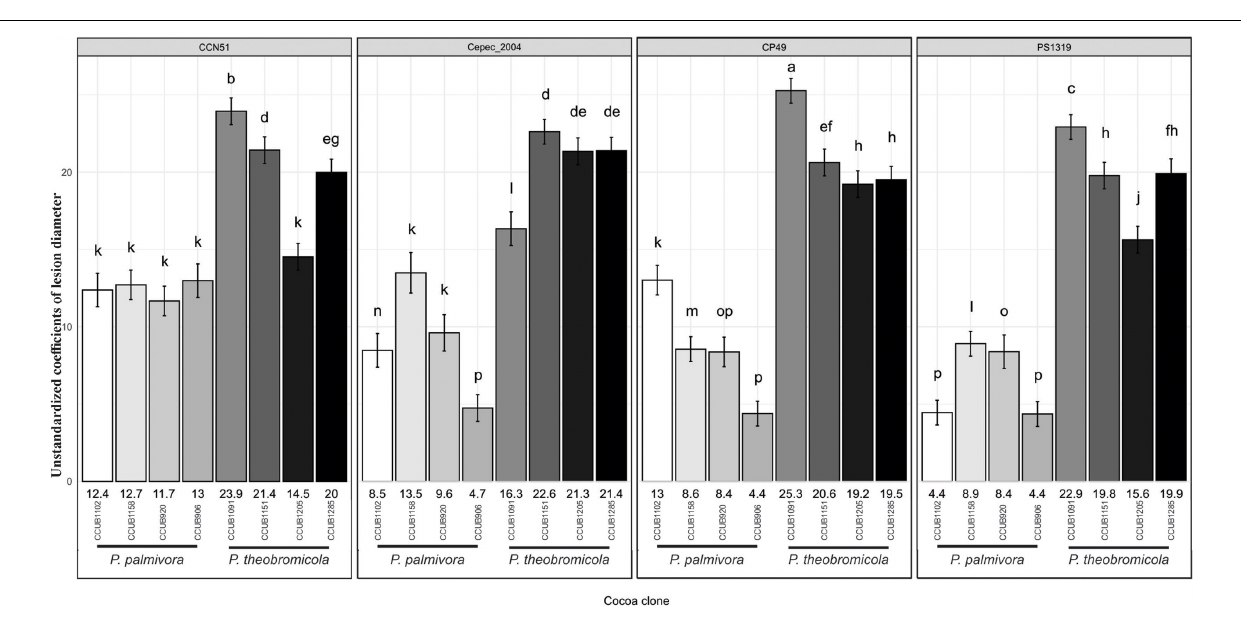
reinforcing the genetic differences between these two